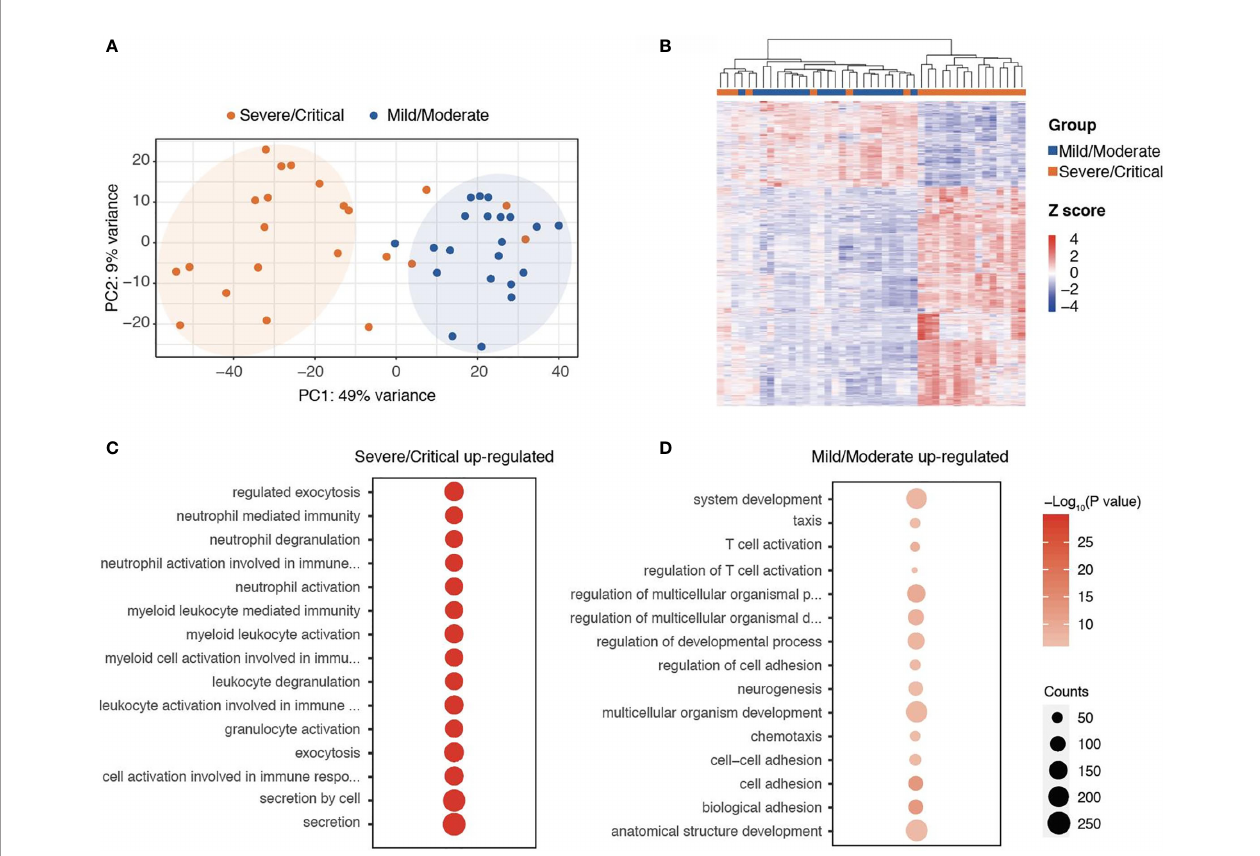
FIGURE 1 | RNA-seq analysis showing the transcriptional programs in blood cells related to the severity of COVID-19. (A) PCA analyses of the transcriptome of PBMC cells in mild/moderate and severe/critical COVID-19. (B) Heatmap showing the differentially expressed genes in PBMC cells between mild/moderate and severe/critical COVID-19. (C, D) Functional annotation of genes correlated with the risk of secondary infection during the initial